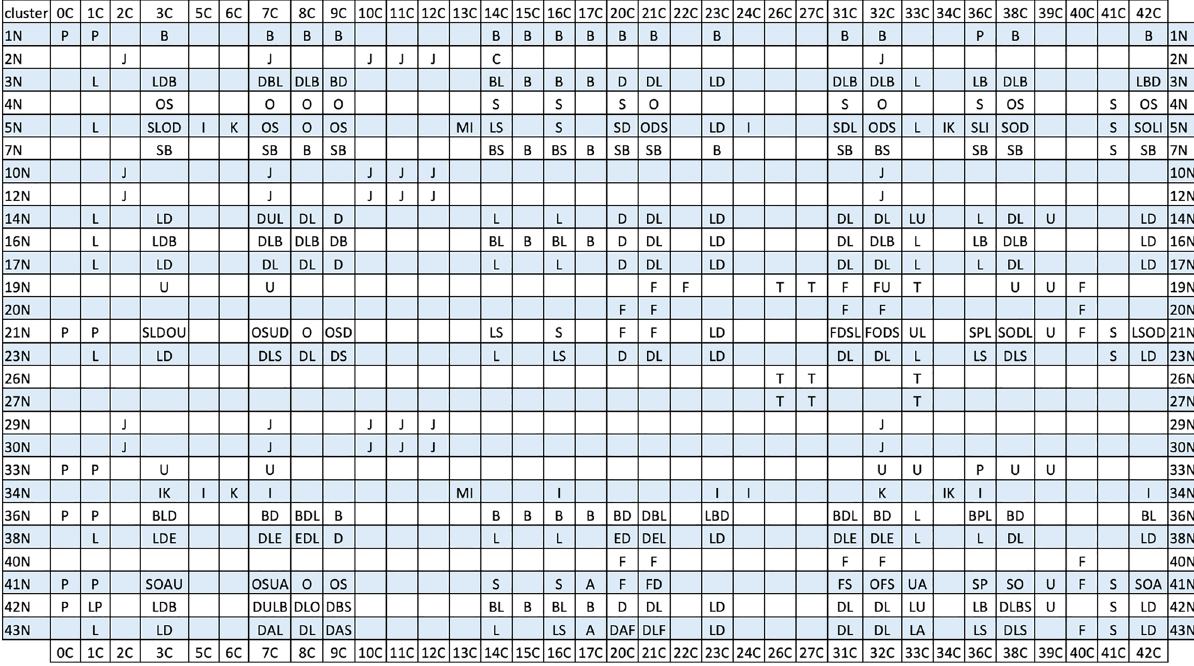
Table 2. Tissue of origin of cancers. Cancer clusters (horizontal) vs. normal clusters (vertical). A cancer type is listed if the product of its number of cancer tissue samples times its number of normal tissue samples for a cluster is ≥ 10% of that of the cancer type with the largest product within the table’s cell. Tissue clusters with ≥ 5 samples were used in the analysis. Cancer types at each location are listed with decreasing values from left to right. TCGA cancers: A (BLCA, bladder urothelial carcinoma), B (BRCA, breast invasive carcinoma), C (CHOL, cholangiocarcinoma), D (LUSC, lung squamous cell carcinoma), E (CESC, cervical squamous cell carcinoma and endocervical adenocarcinoma), F (ESCA, esophageal carcinoma), I (KIRC, kidney renal clear cell carcinoma), J (LIHC, liver hepatocellular carcinoma), K (KIRP, kidney renal papillary cell carcinoma), L (LUAD, lung adenocarcinoma), M (KICH, kidney chromophobe), O (COAD, colon adenocarcinoma), P (PRAD, prostate adenocarcinoma), S (STAD, stomach adenocarcinoma), T (THCA, thyroid carcinoma), U (UCEC, uterine corpus endometrial carcinoma). H (HNSC, head and neck squamous cell carcinoma), R (READ, rectum adenocarcinoma), and UCS (uterine carcinosarcoma) have too few tissue